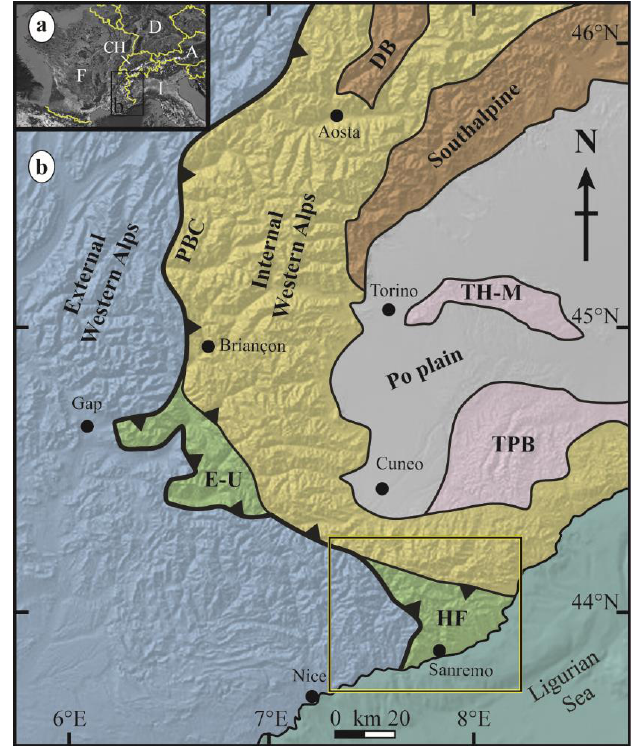
Figure 1. ( a ) Location of the study area. ( b ) Tectonic sketch of the Western and Ligurian Alps [12]. Tectonic units are grouped into Internal (Piedmont, Piedmont–Ligurian and Briançonnais) and External (Provençal–Dauphinois, Helvetic and External Massifs) domains. The yellow box shows the location of the Helminthoid Flysch nappes (HF) above the Penninic Basal Contact (PBT). DB: Dent Blanche nappe (Austroalpine domain); E-U: Embrunais-Ubaye nappes; TH-M: Torino hill and Monferrato high; TPB: Tertiary Piedmont